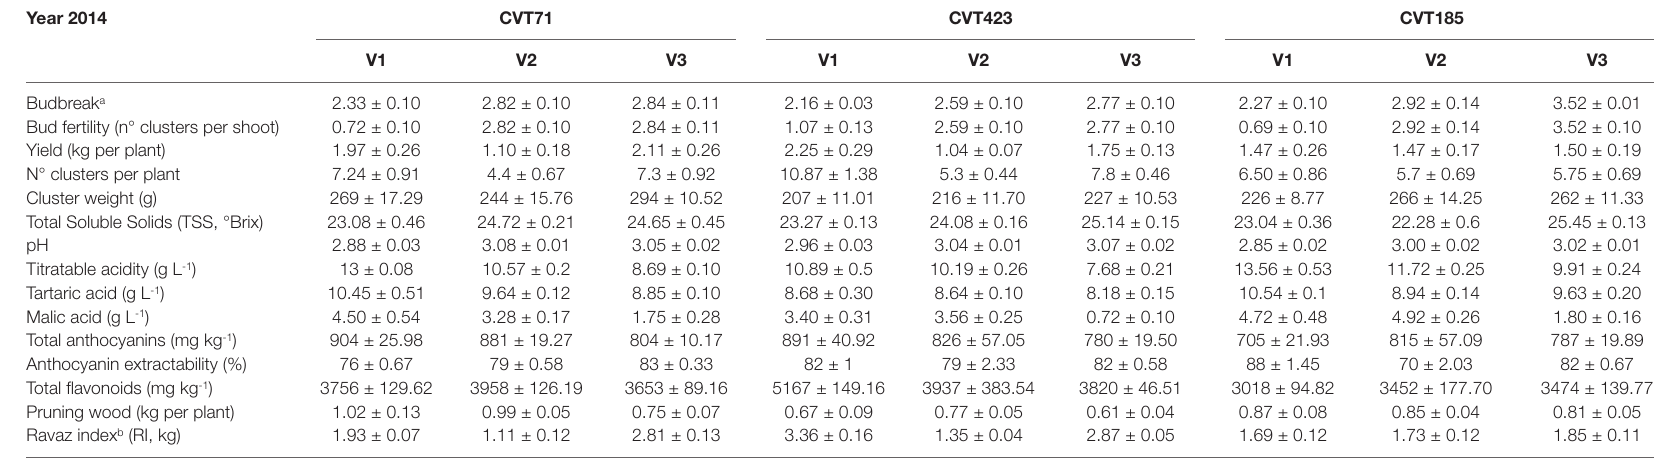
TABlE 2 | Measurements of agronomical parameters, quantity and quality features of the studied ‘Nebbiolo’ clones (CVT71, CVT423 and CVT185) grown in three different vineyards of the Langhe area (V1, V2, V3) in 2014. Data are means ± standard error ( n = 21 ). Results of ANOVA analysis are detailed below the